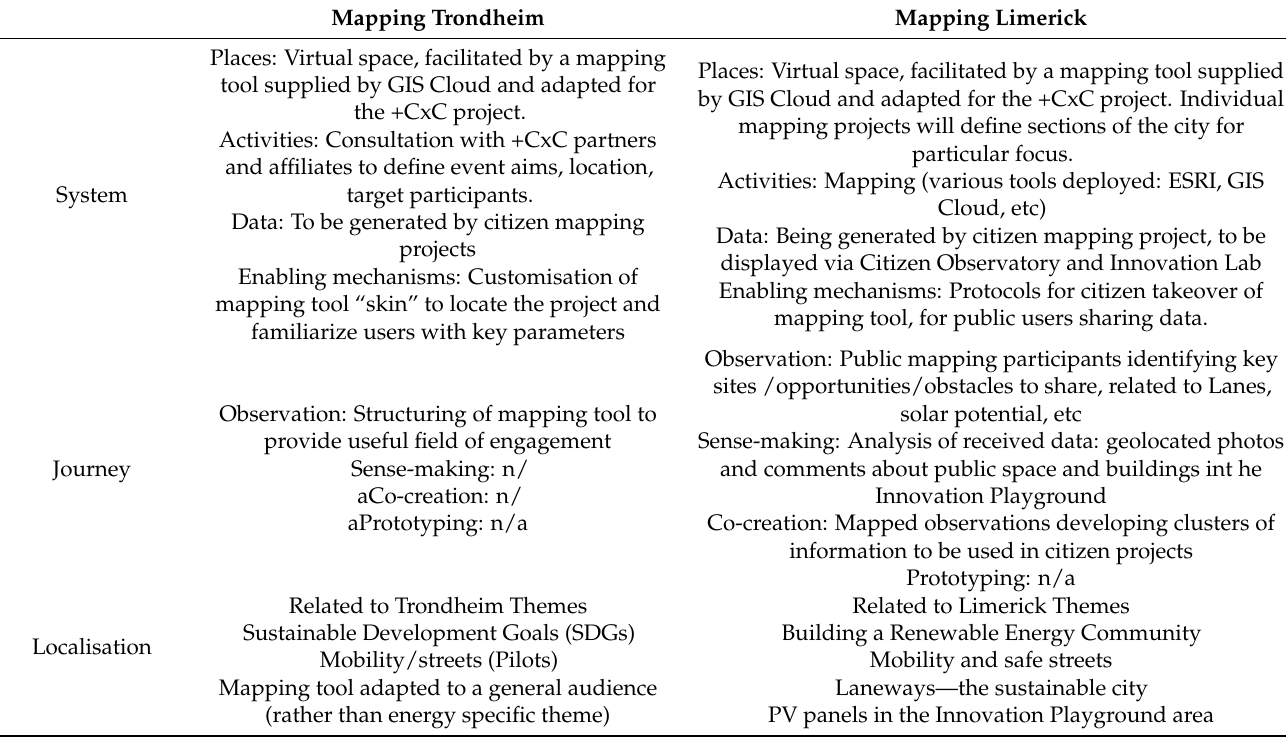
Table 5. Table of Reporting Mapping Events (2019 to